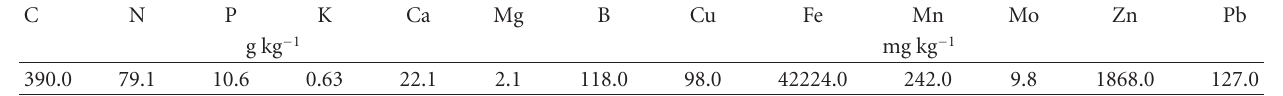
Table 2: Contents of nutrients and Pb in original sewage sludge used in this study.